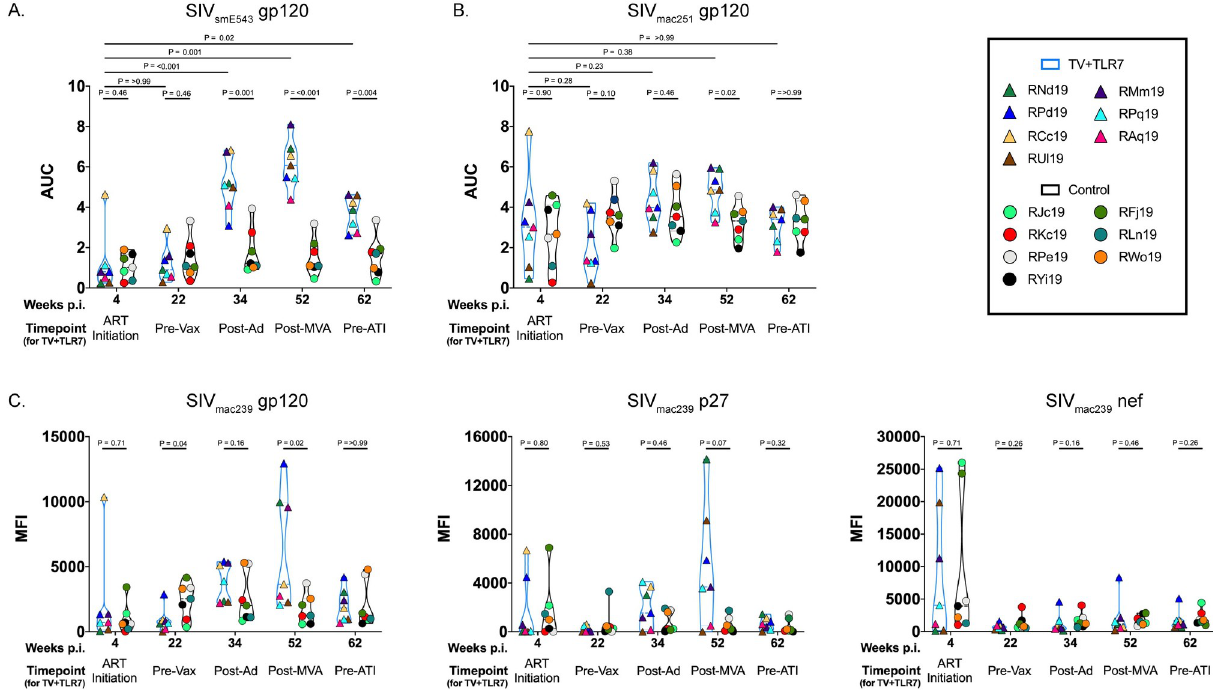
Fig 5. Humoral response measured by ELISA and BAMA to therapeutic vaccination in SIV-infected, ART-treated infant RMs. SIV-specific antibodies directed against gp120 from (A) vaccine strain, SIV smE543 , and (B) challenge strain, SIV mac251 , were quantified by binding ELISA area under the curve (AUC) at week 4 prior to ART initiation, week 22 prior to vaccination, week 34 after priming with two doses of Ad48, week 52 after boosting with two doses of MVA, and week 62 prior to analytical treatment interruption (ATI) in TV+TLR7 RMs and equivalent time points for controls. (C) SIV- specific antibodies directed against SIV mac239 gp120, p27, and Nef were measured by Binding Antibody Multiplex Assay (BAMA) at same time points described above. Experimental groups were compared using a two-sided Mann-Whitney test and timepoints within groups were compared using the non-parametric Friedman test with Dunn’s multiple comparison test to correct for multiple comparisons (P < 0.05 was considered significant).